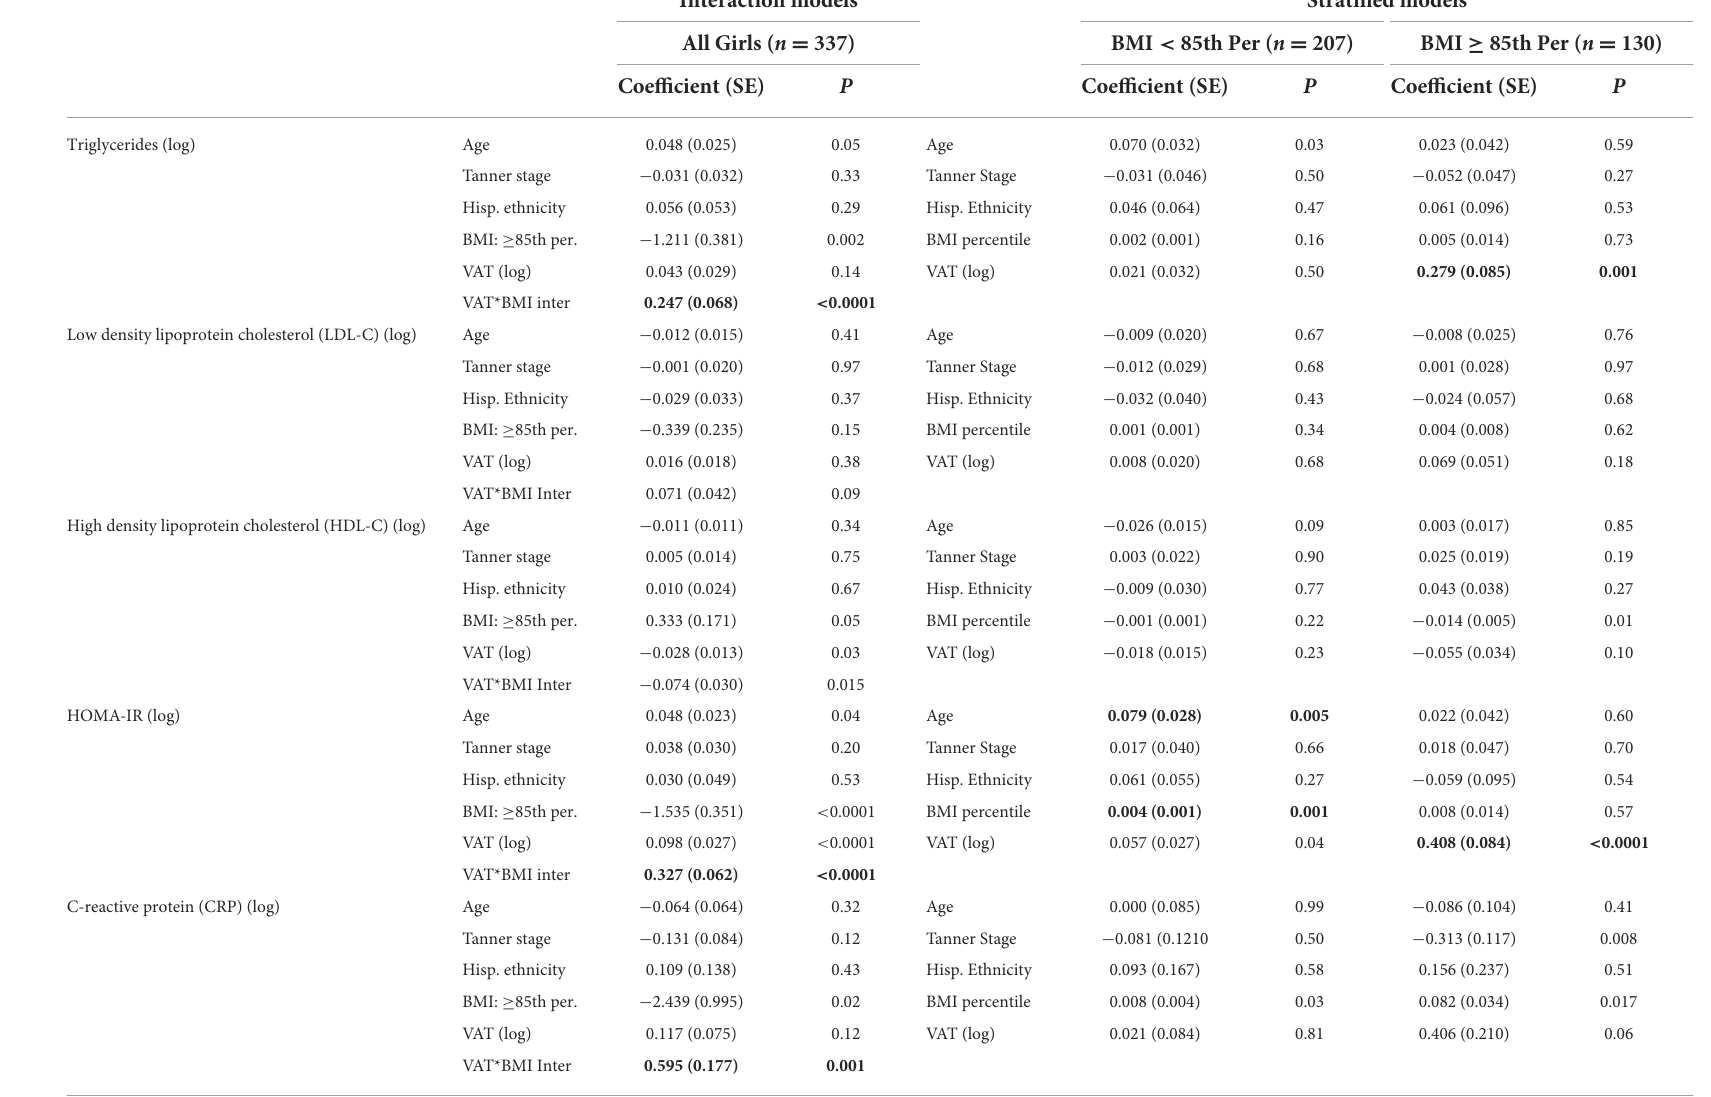
TABLE 2 Multiple linear regression models assessing the relationship between visceral adipose tissue and cardiometabolic risk factors. Interaction models Stratified